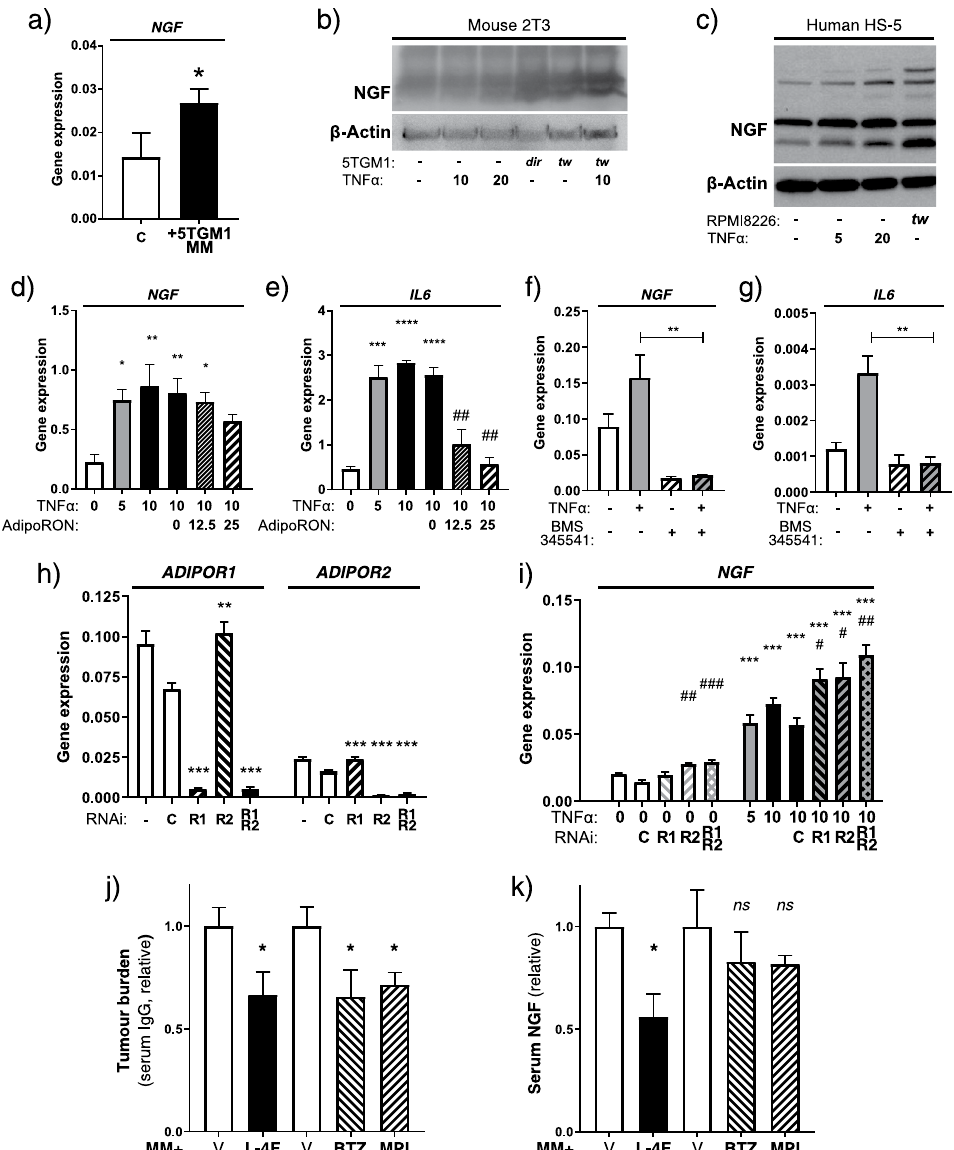
Figure 4. Regulation of NGF in stromal cell types by multiple myeloma. ( a ) TaqMan qRT-PCR for Ngf gene expression 2T3 mouse pre-osteoblasts in control or 5TGM1-MM-transwell conditions for 72 hours. Statistical comparison by unpaired Student’s t -test. ( b ) Western blot for NGF protein in mouse 2T3 cells treated with recombinant mouse TNF- α , or with direct ( dir ) or transwell ( tw ) 5TGM1 interaction. ( c ) Western blot for NGF protein in human HS-5 bone stromal cells after TNF- α or RPMI8226 transwell treatment. Glycosylated (53 kDa and 60 kDa) and unglycosylated (27 kDa and 30 kDa) NGF are detected. Original uncropped images are available as Supplementary Material. ( d ) Primary KaLwRij mouse osteoblasts were treated with TNF- α (concentration in ng/mL) in combination with AdipoRON (concentration in µ M) for 8 hours before cell lysis, then qPCR performed for Ngf and ( e ) Il6 transcript. Asterisks indicated comparison to 0 ng/mL TNF- α control, hashes indicate comparison to the 10 ng/mL TNF- α+ 0 µ M AdipoRON column. ( f ) 2T3 cells were treated with 1 ng/mL TNF- α and/or 10 µ M BMS-345541, or equivalent volume vehicle, for 8 hours before cell lysis, then qPCR performed for Ngf and g) Il6 transcript. h) qPCR of ADIPOR1 and ADIPOR2 transcript levels in 2T3 cells after knockdown for 24 hours with a negative control siRNA (“C”), an siRNA targeted towards ADIPOR1 (“R1”) or ADIPOR2 (“R2”), or both simultaneously. ( i ) Relative NGF transcript levels in siRNA-treated 2T3 cells as indicated under control or TNF- α stimulation (concentration in ng/mL) for 24 hours. Asterisks indicate comparisons to untransfected 0 ng/mL TNF- α control, hashes indicate comparison to the siRNA-Control column with the same TNF- α concentration. All qPCR-quantified gene expression shown is normalised to the average of two reference genes ( GAPDH and POLR2A ). ( j ) Tumour burden and ( k ) serum NGF protein in 5TGM1-MM-bearing KaLwRij mice, as detected by serum ELISA for IgG2b and NGF respectively, after L-4F, Melphalan (“MPL”), bortezomib (“BTZ”) or vehicle alone (“V”) treatment. Statistical comparisons ( d – k ) by one-way ANOVA with Dunnett’s multiple comparisons test. All statistical comparisons: ns : not significant, * p < 0.05; ** p < 0.01; *** p <